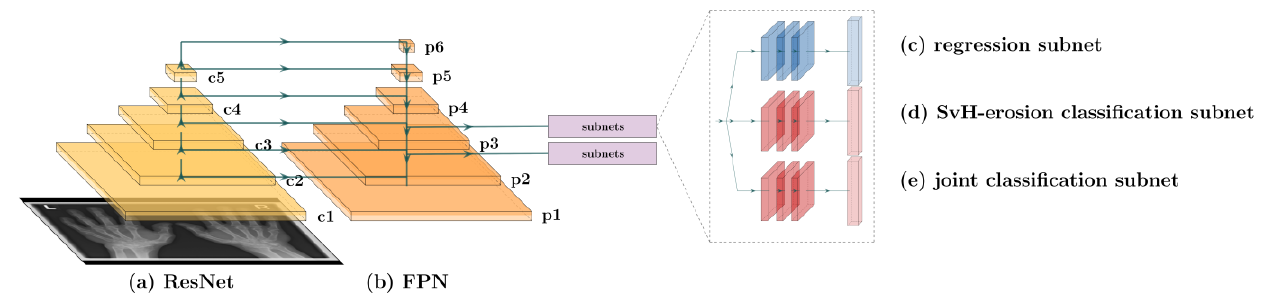
Figure 3. Schematic representation of the RetinaNet, which was used to detect and classify X-ray hand images automatically. The residual neural network (ResNet) ( a ) compressed the global image information. Then, the compressed data are merged by local skip connections (blue arrows) and processed in the feature pyramid network (FPN) ( b ). The regression subnetwork ( c ) and the two classification subnetworks ( d , e ) were then applied to outputs p2 and p3. Furthermore, batch normalization and Rectified Linear Unit (ReLU) were used as the activation function.